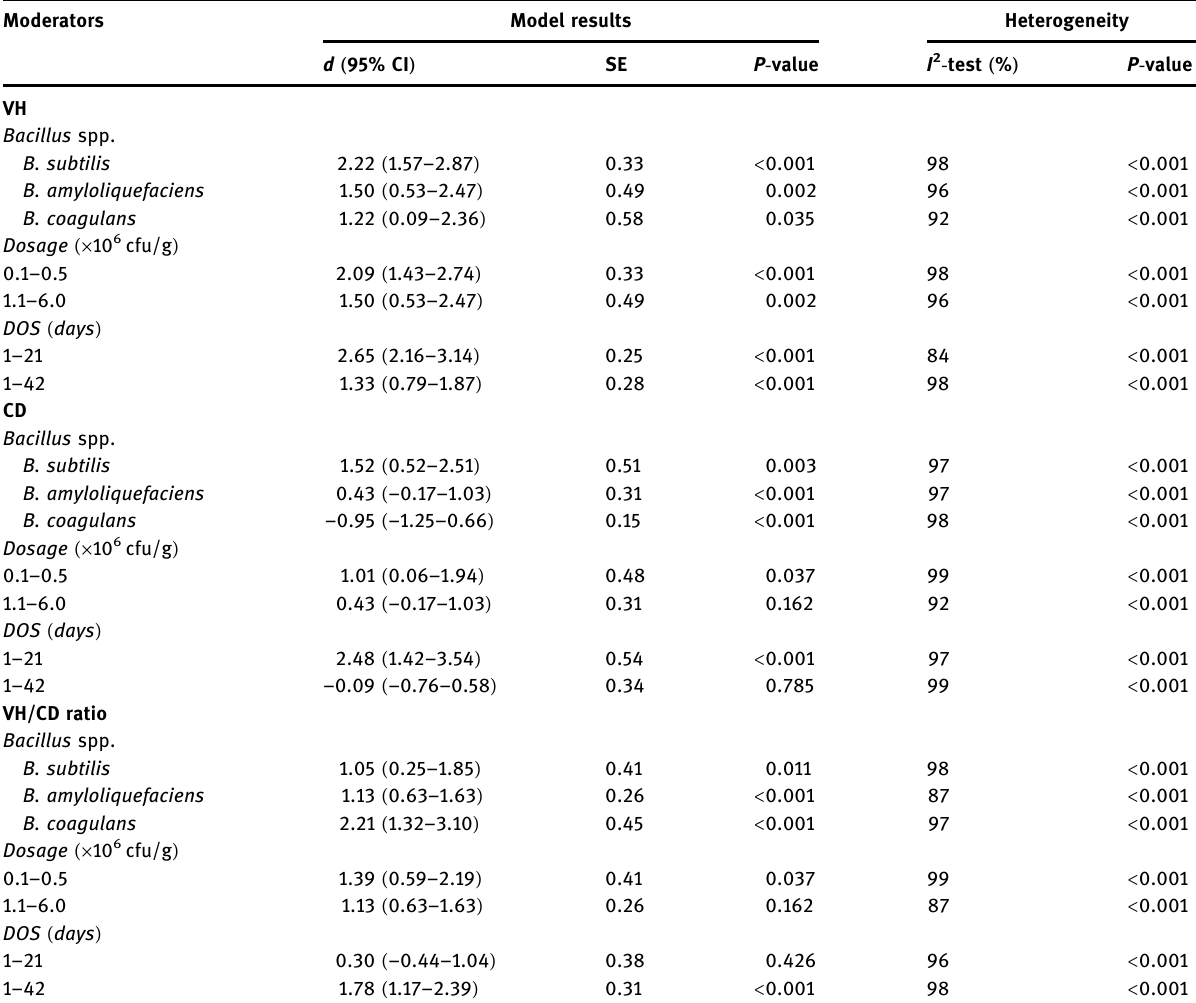
Table 5: Impact of moderators on jejunal histomorphometric traits in broiler fed Bacillus - supplemented diets Moderators Model results